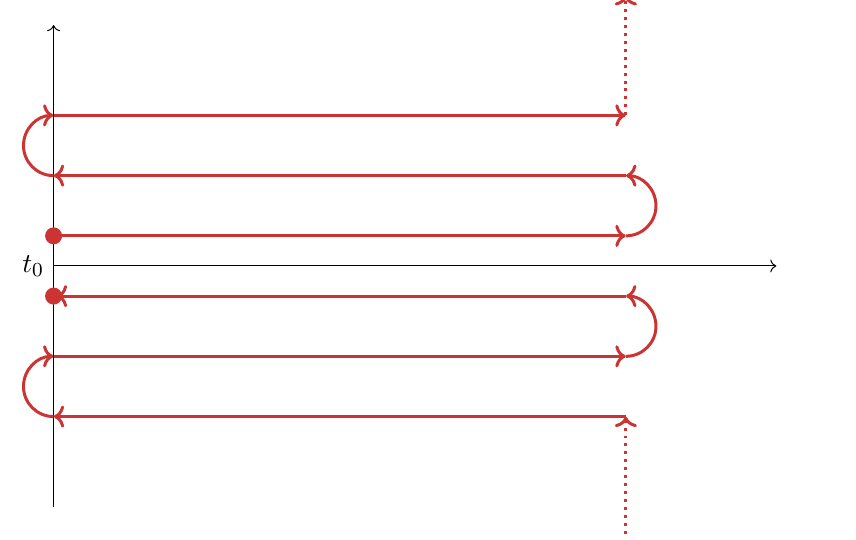
Figure 5 . The k-OTO contour computing the out-of-time-ordered correlation functions encoded in the generating functional